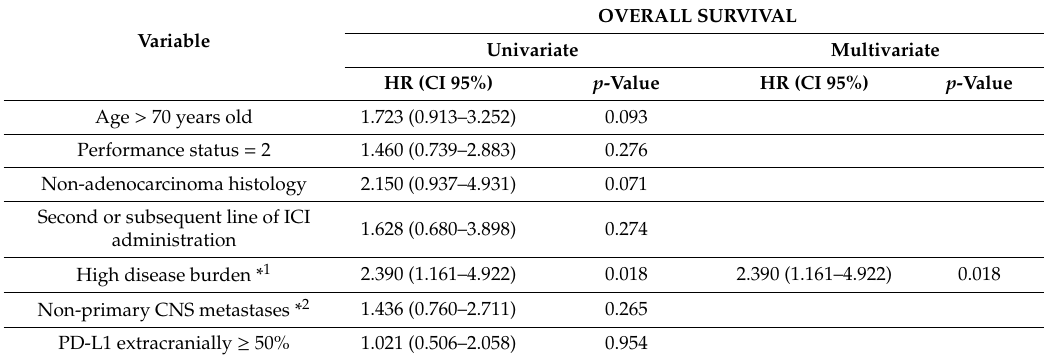
Table 4. Univariate and multivariate analysis of the e ff ect of the studied parameters on overall survival.